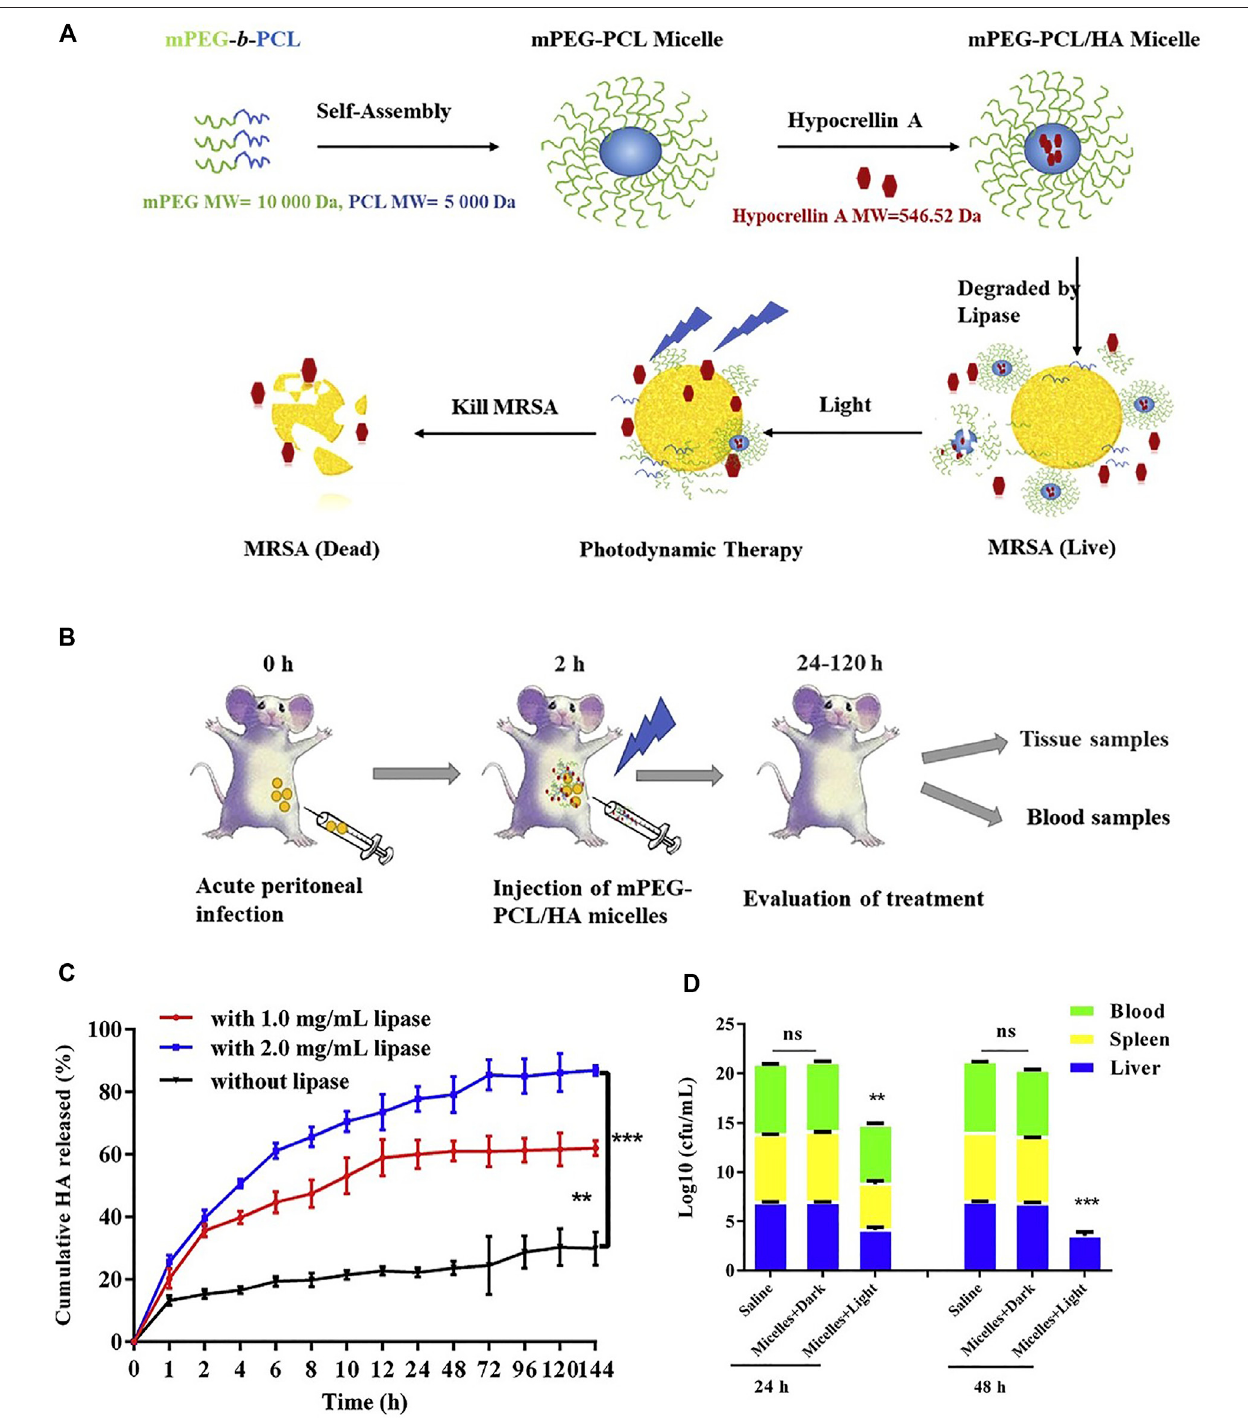
FIGURE 12 | (A) Schematic illustration of the mPEG-PCL/HA micelles for enhanced photodynamic antibacterial activity; (B) schematic illustration of the mPEG- PCL/HAmicelles for the in vivo treatment; (C) cumulative release of HA from micelles without or with lipase(1.0, 2.0 mg/ml); (D) total bacterial counts in the liver, spleen, and blood of mice after being treated with mPEG-PCL/HA micelles (HA dose: 5 mg/kg) in dark or light irradiation for 24 and 48 h. Reprinted with permission from Guo et al. (2020).